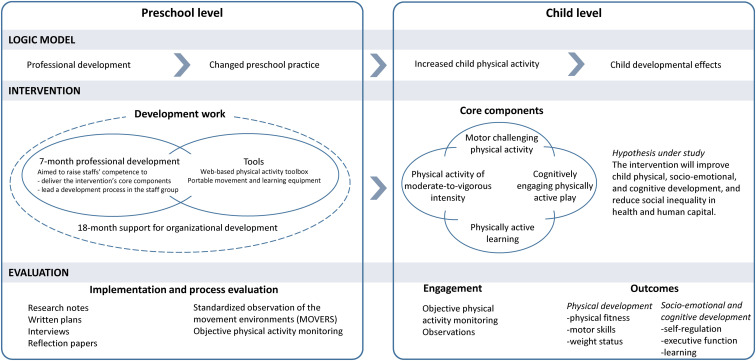
The two-level intervention model.